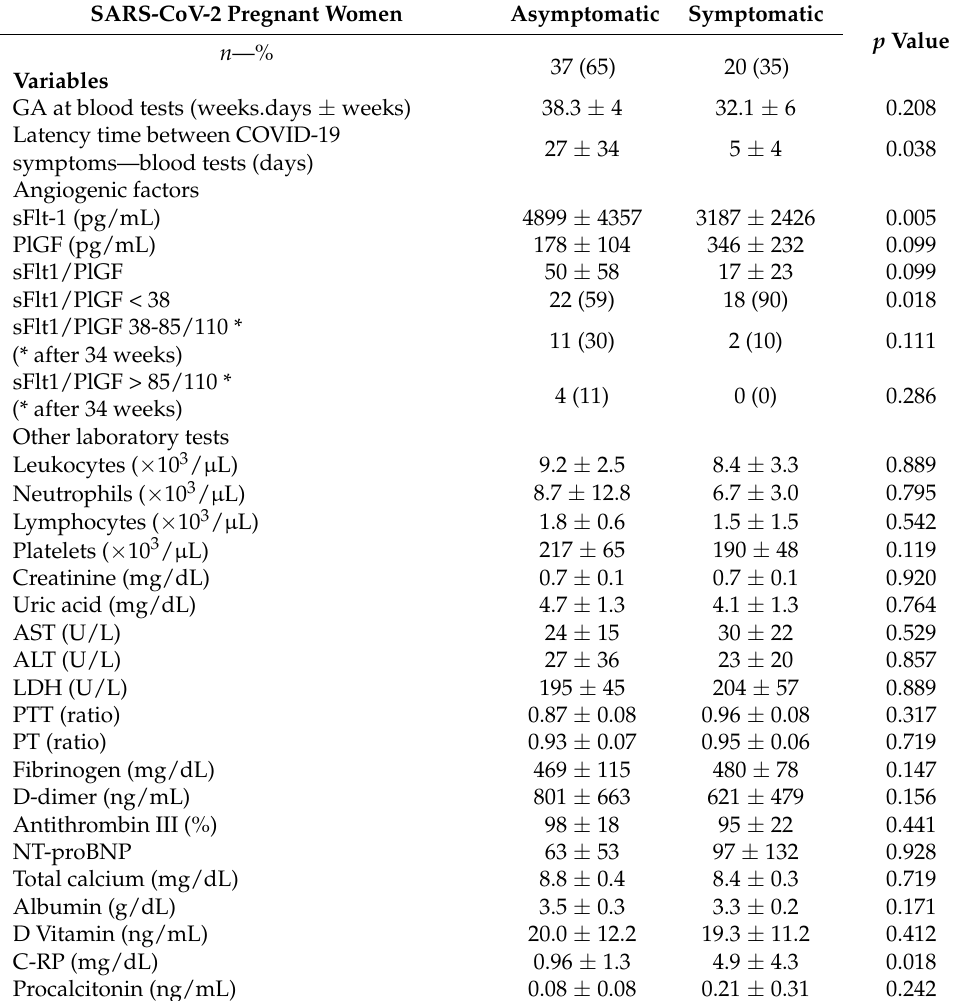
Table 5. Blood tests performed at the hospital access in the study population, comparing symptomatic vs. asymptomatic women [Mean; standard deviation—SD; n ;